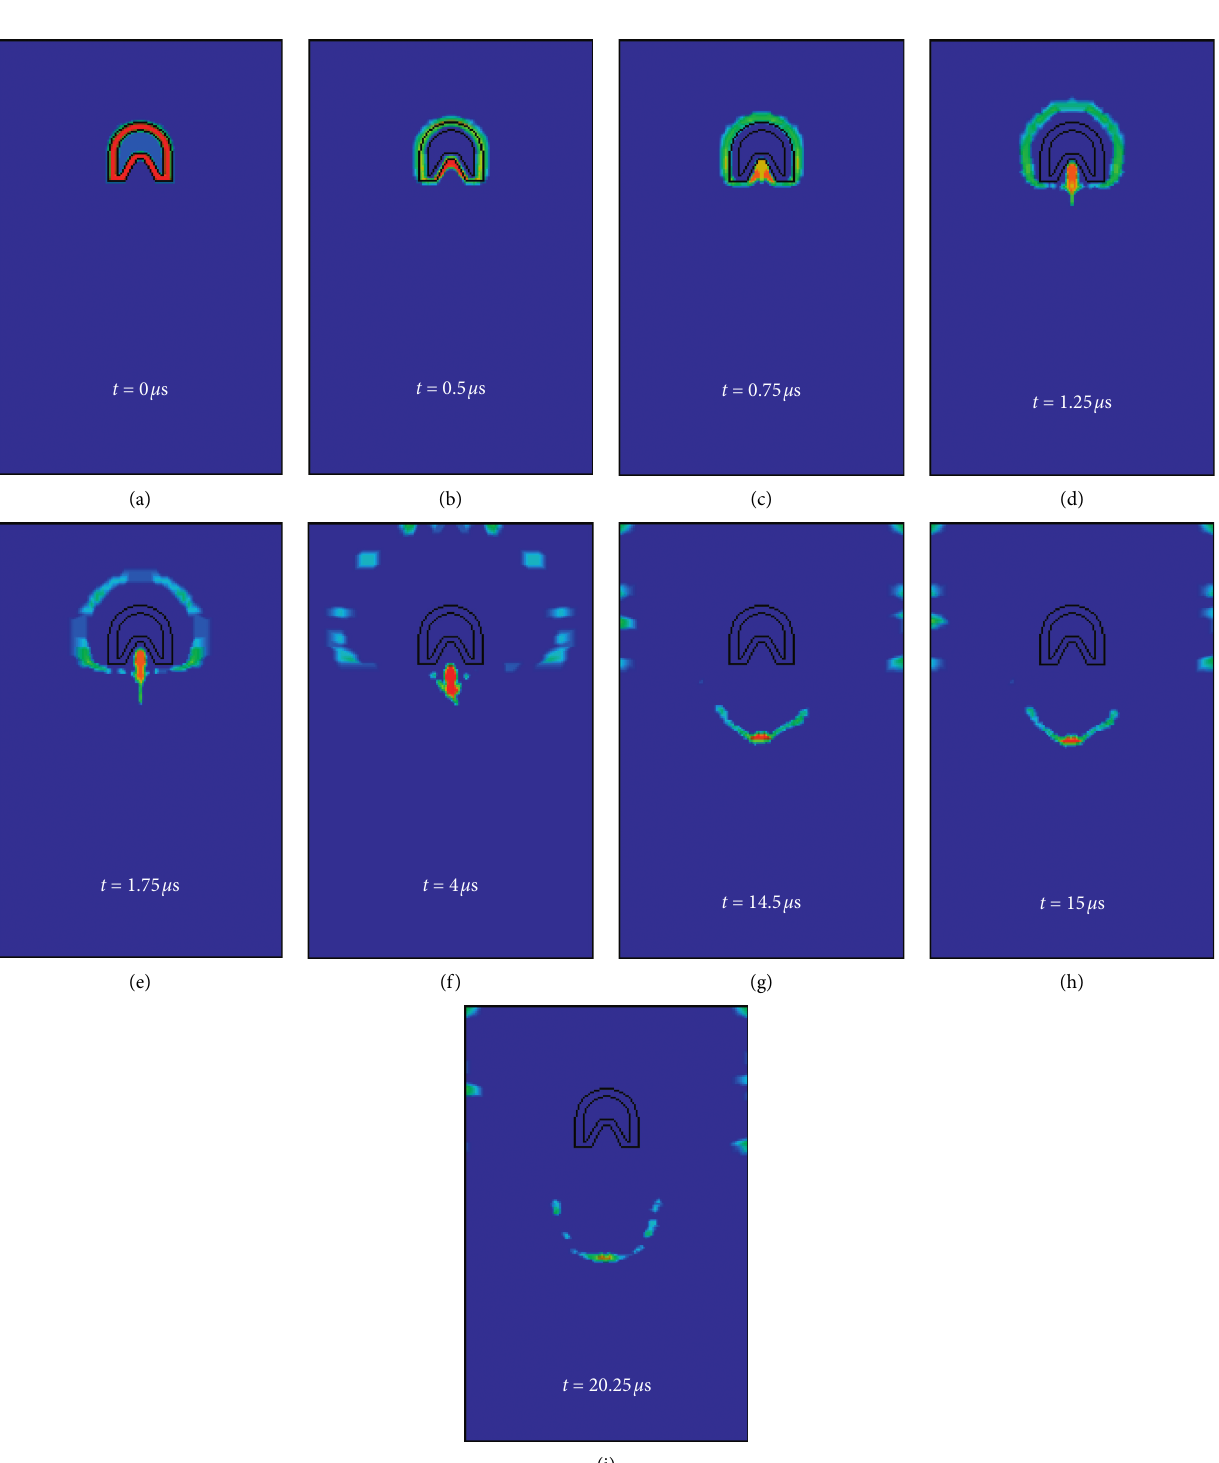
Figure 5: Change of shaped charge jet